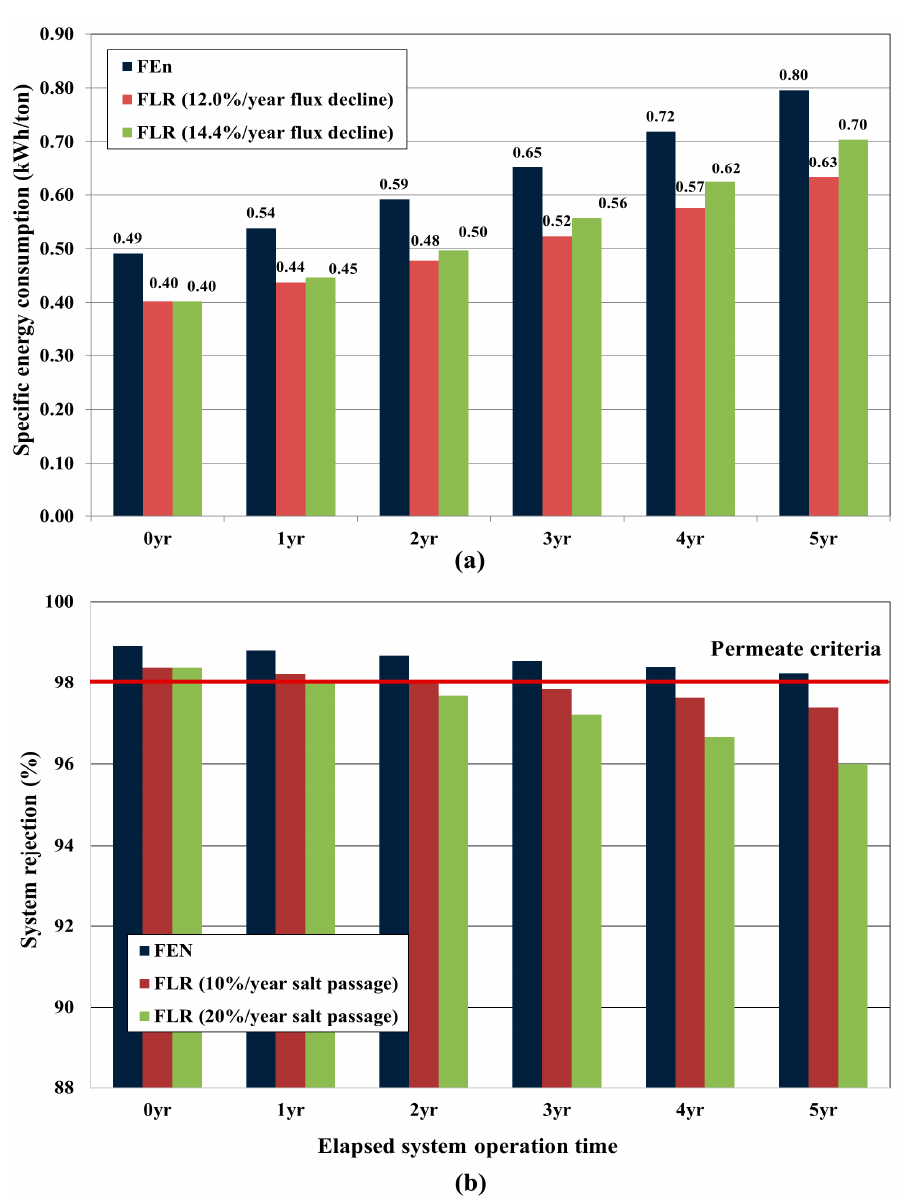
Figure 15. Simulation study results for which the design parameters obtained from pilot test were adopted: ( a ) Predicted specific energy consumption (kWh) comparison as to the elapsed operation time; ( b ) Predicted system rejection comparison as to the elapsed operation time. Table 8. Required quantity of LPRO FLR elements to meet the designated permeate water criteria 98% system salt rejection.